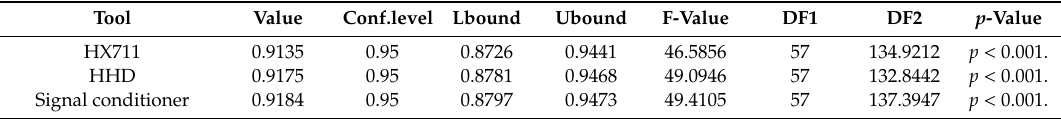
Table 6. Session two results of ICC calculation comparing each participant’s MVIC trials among themselves for each instrument and their 95% confident intervals, using a single rating, absolute-agreement, 2-wat mixed-effects